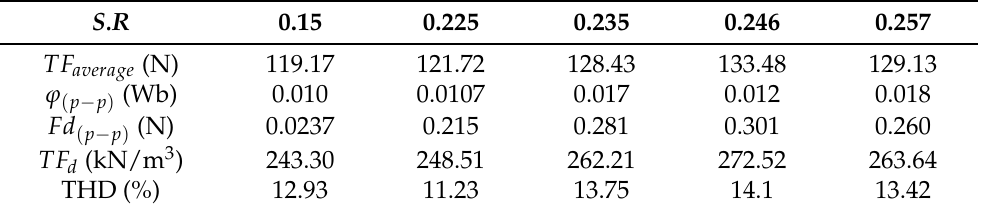
Table 2. Performance indicator.